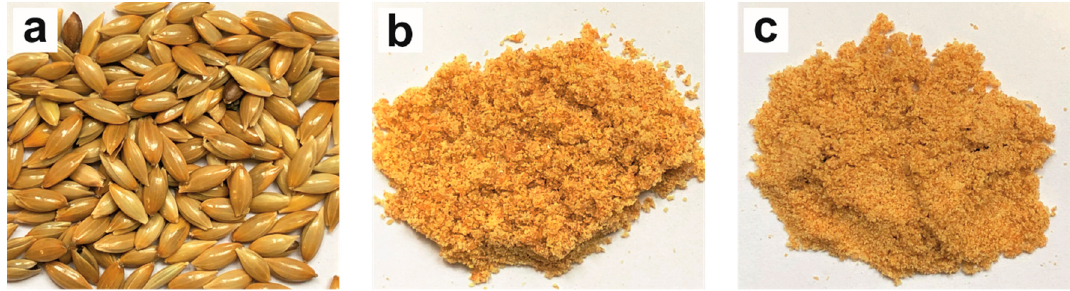
Figure 1. Images corresponding to ( a ) raw flaxseeds (FS); ( b ) flaxseed flour (FF) obtained by grinder (CFF); ( c ) flaxseed flour (FF) obtained by ultracentrifuge